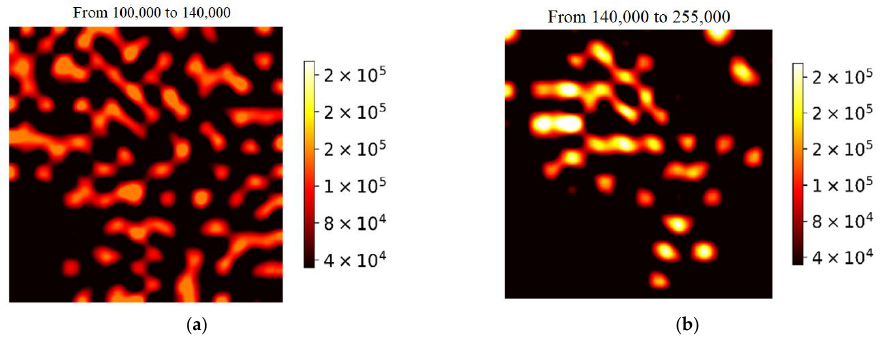
Figure 10. ( a ) Histograms of the distribution of the area value of the MG SERS peak located at 1177 cm −1 . ( b ) Histograms of the distribution of the area value of the phthalocyanine SERS peak located at 1350 cm −1 .